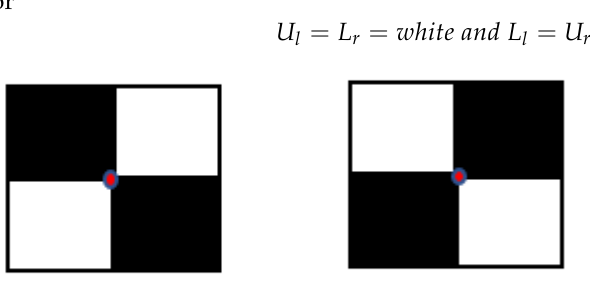
Figure 7. Local corner selection.